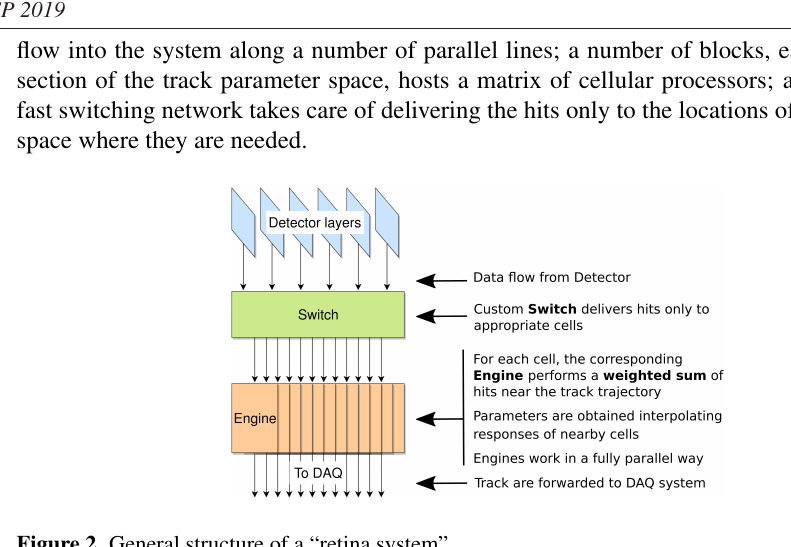
Figure 2. General structure of a “retina system”.